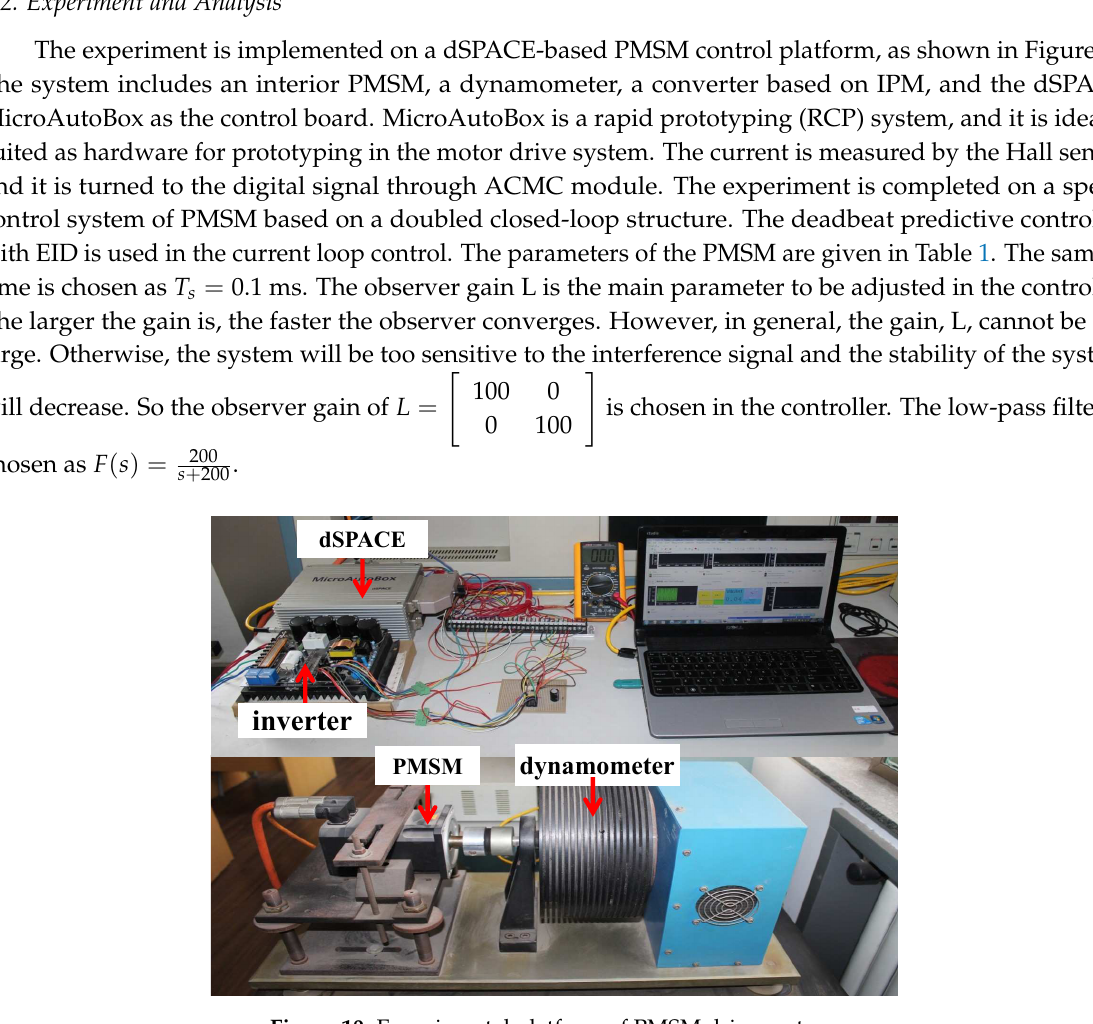
Figure 10. Experimental platform of PMSM drive